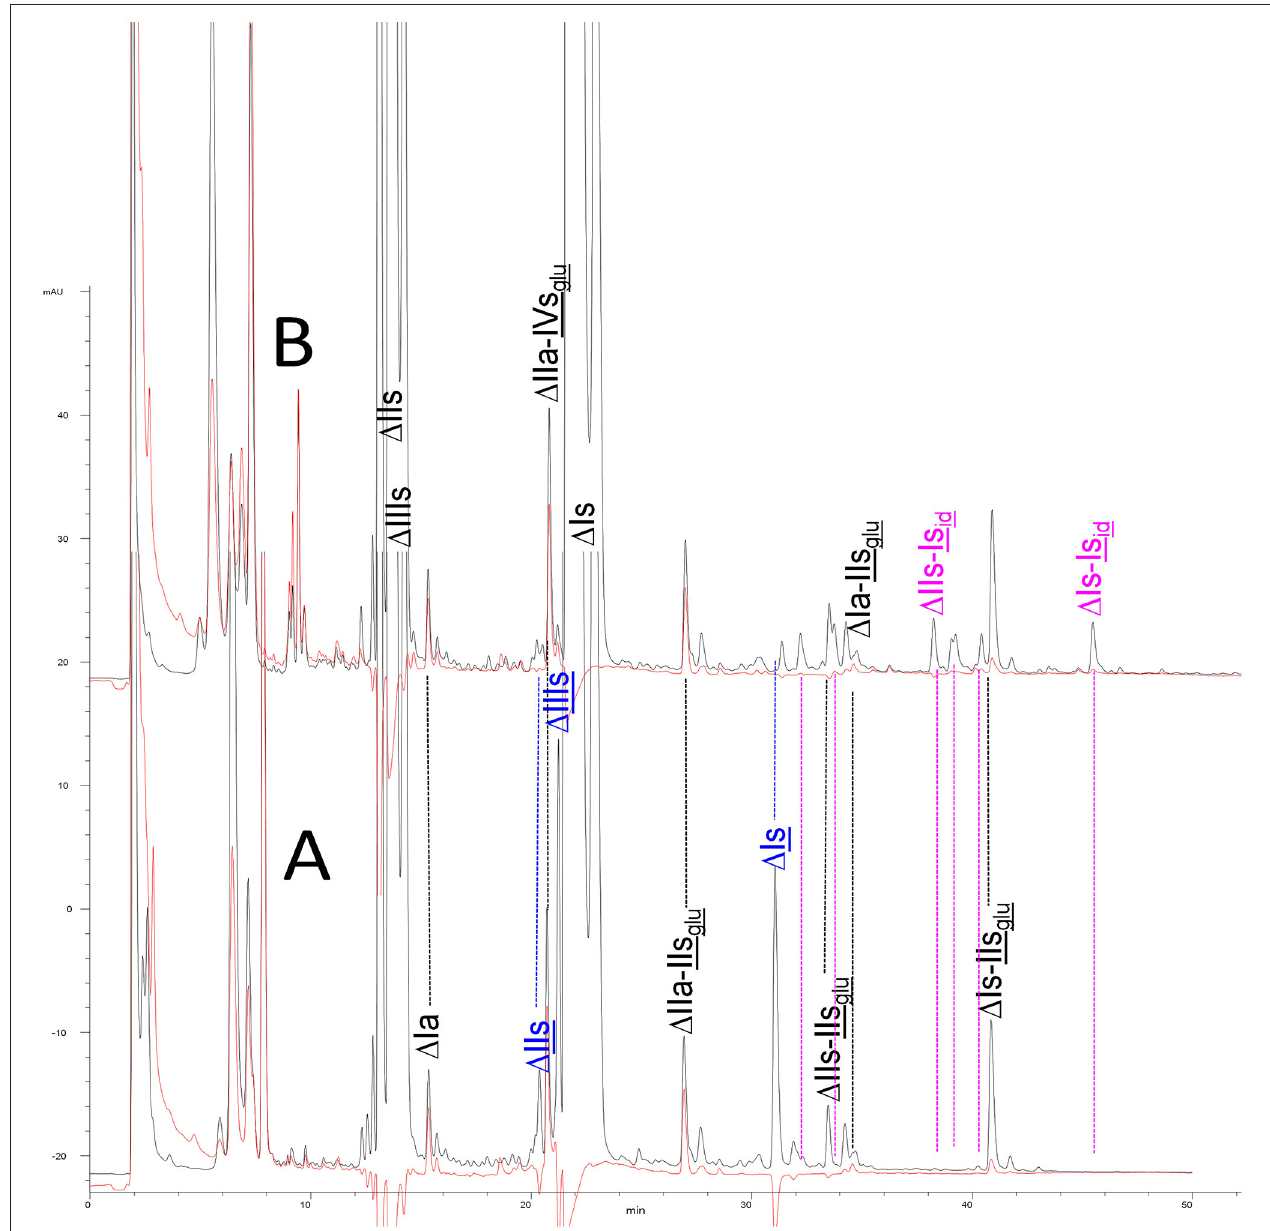
FIGURE 1 | Comparison of digests from bovine mucosal heparin by (A) heparinase I + II + III, and (B) heparinase II, separated on a Carbopack AS11 column. Black line ( — ): UV 232nm; red line ( — ): UV 202 nm-242nm (UV signal specific to acetyl